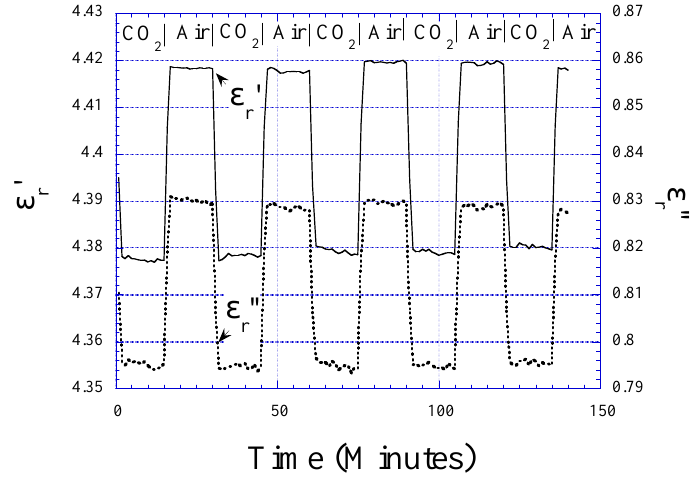
Figure 6. Measured ε air. The changes are reversible, without hysteresis between increasing and decreasing CO